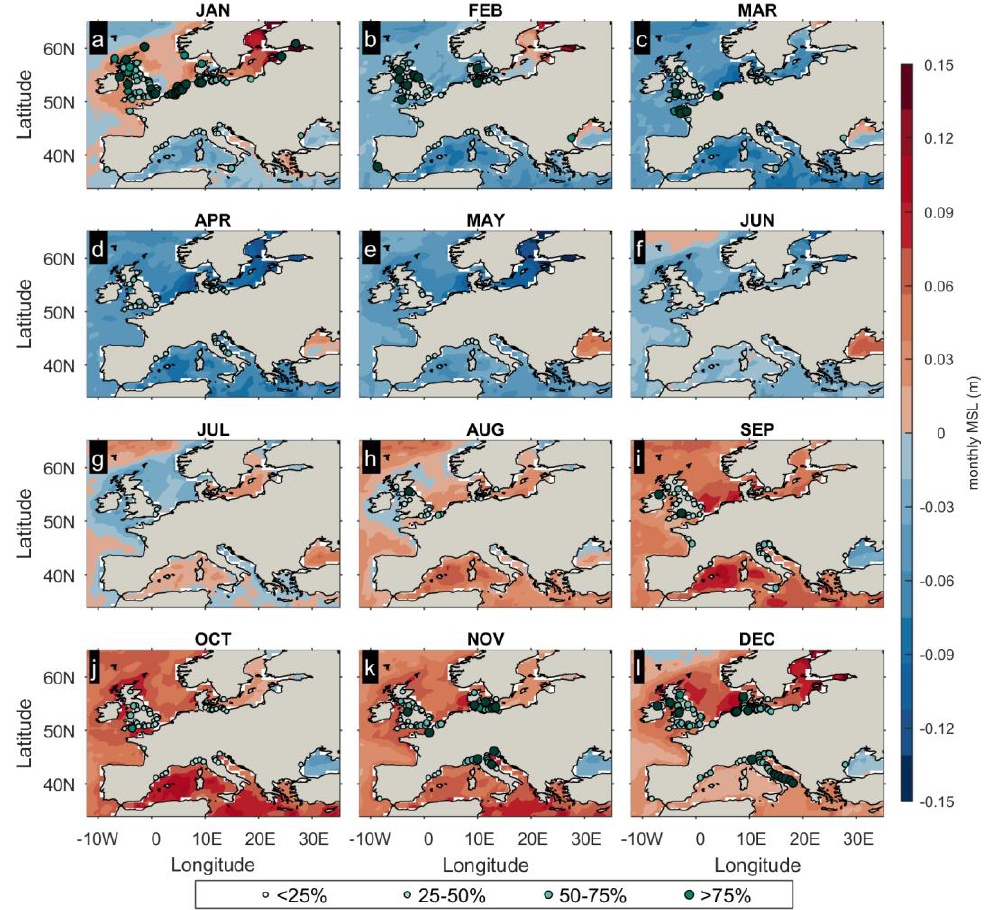
Figure 7. Spatial pattern of the relationship between the CFEEs and the AMMSL (January-2a to December-2l). The dots indicate the position of the coastal storms and the colour intensity refers to their relative monthly frequency in the affected NUTS3 region.